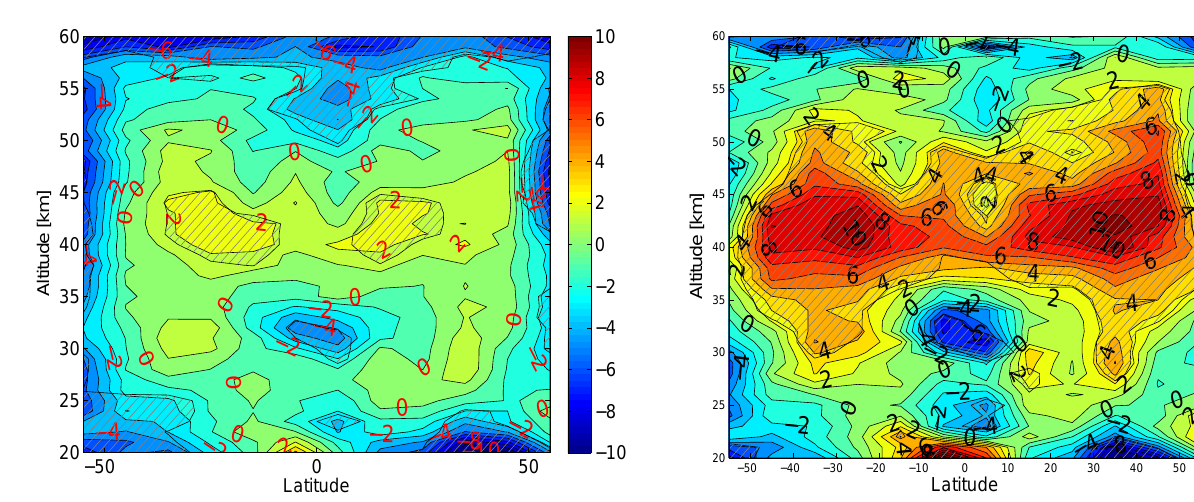
Fig. 15. The ozone trend in % per decade for different latitudes for 1997–2011. Shaded areas show regions where trends are statisti- cally different from zero at the 95% level.